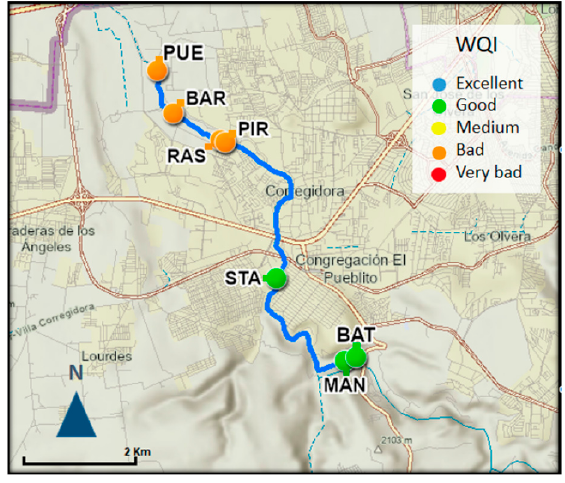
Figure 2. WQI rates of El Pueblito river (blue line) indicating pollution levels in the sampled sites, according to Table 5